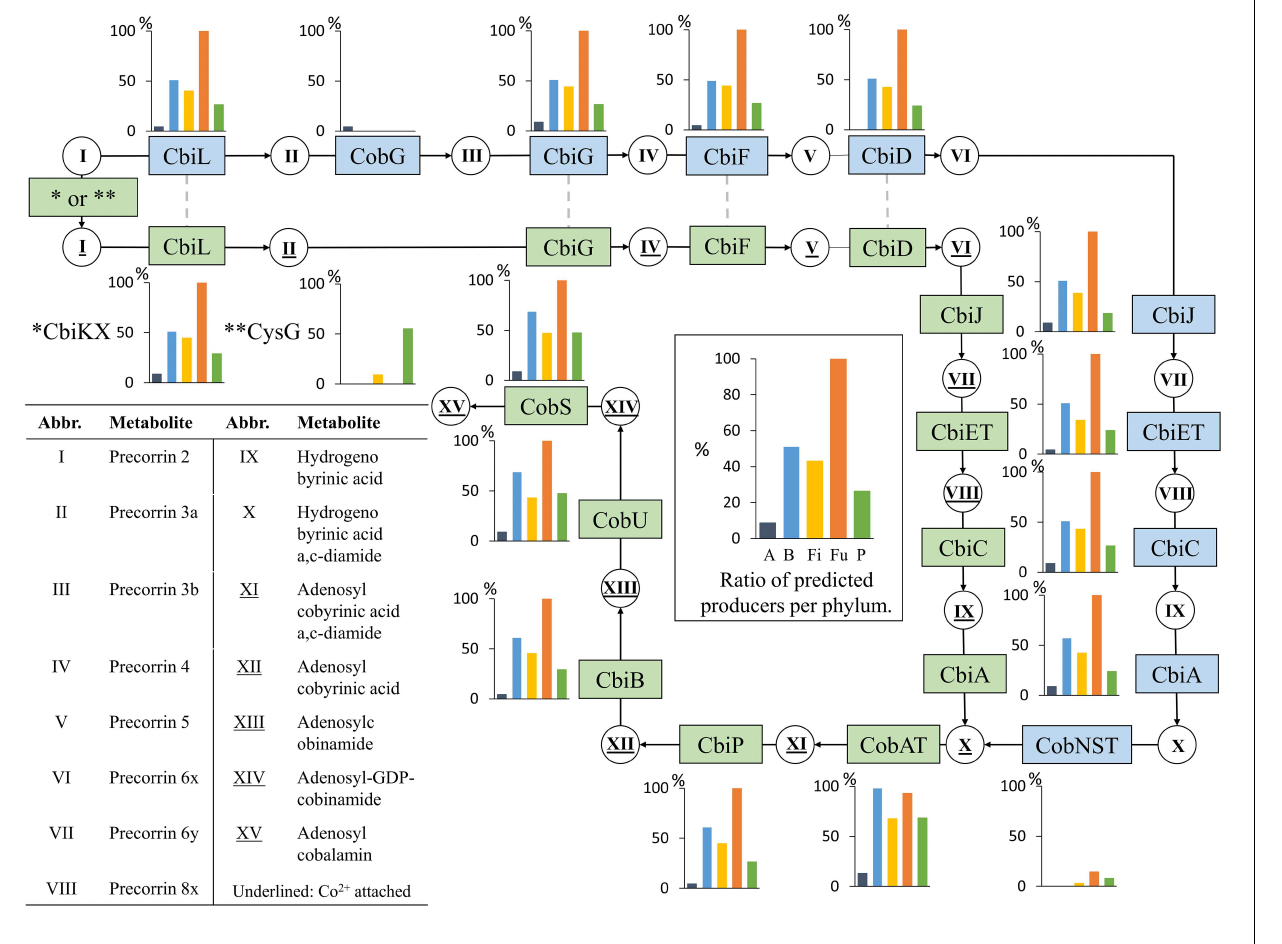
FIGURE 2 | Cobalamin biosynthesis. The cobalamin biosynthesis subsystem contains 17 functional roles (Supplementary Table 2) and 15 metabolites. Refer to Figure 1 for figure descriptions. Note that we show only CbiD since none of the HGM genomes contained CobF. The “ * or ** ”